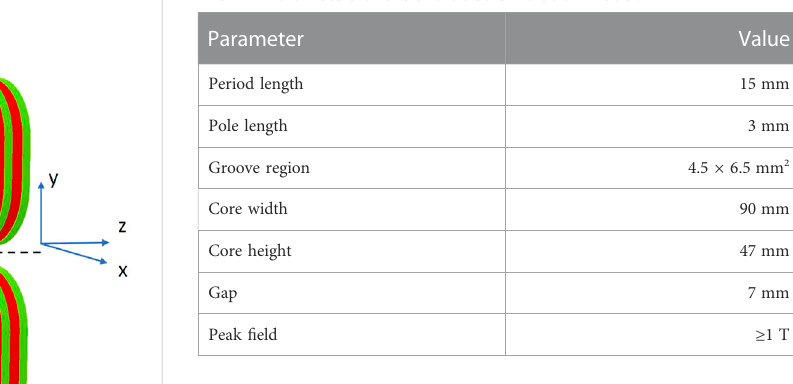
TABLE 1 Parameters of the short SCU simulation